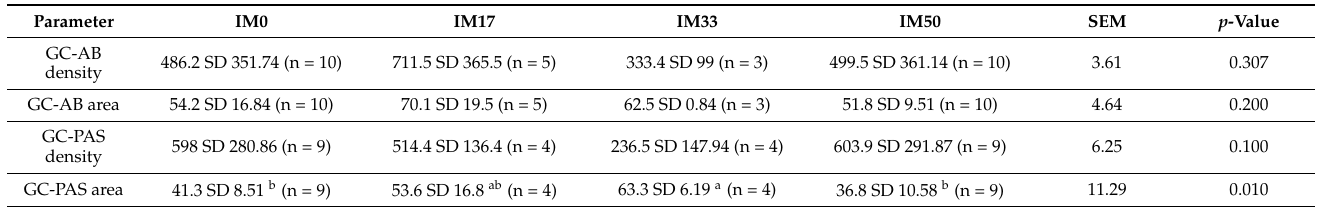
Table 6. Intestinal morphometry in fish fed with different Hermetia illucens meal (IM) dietary inclusion and fishmeal (FM) replacement rates.